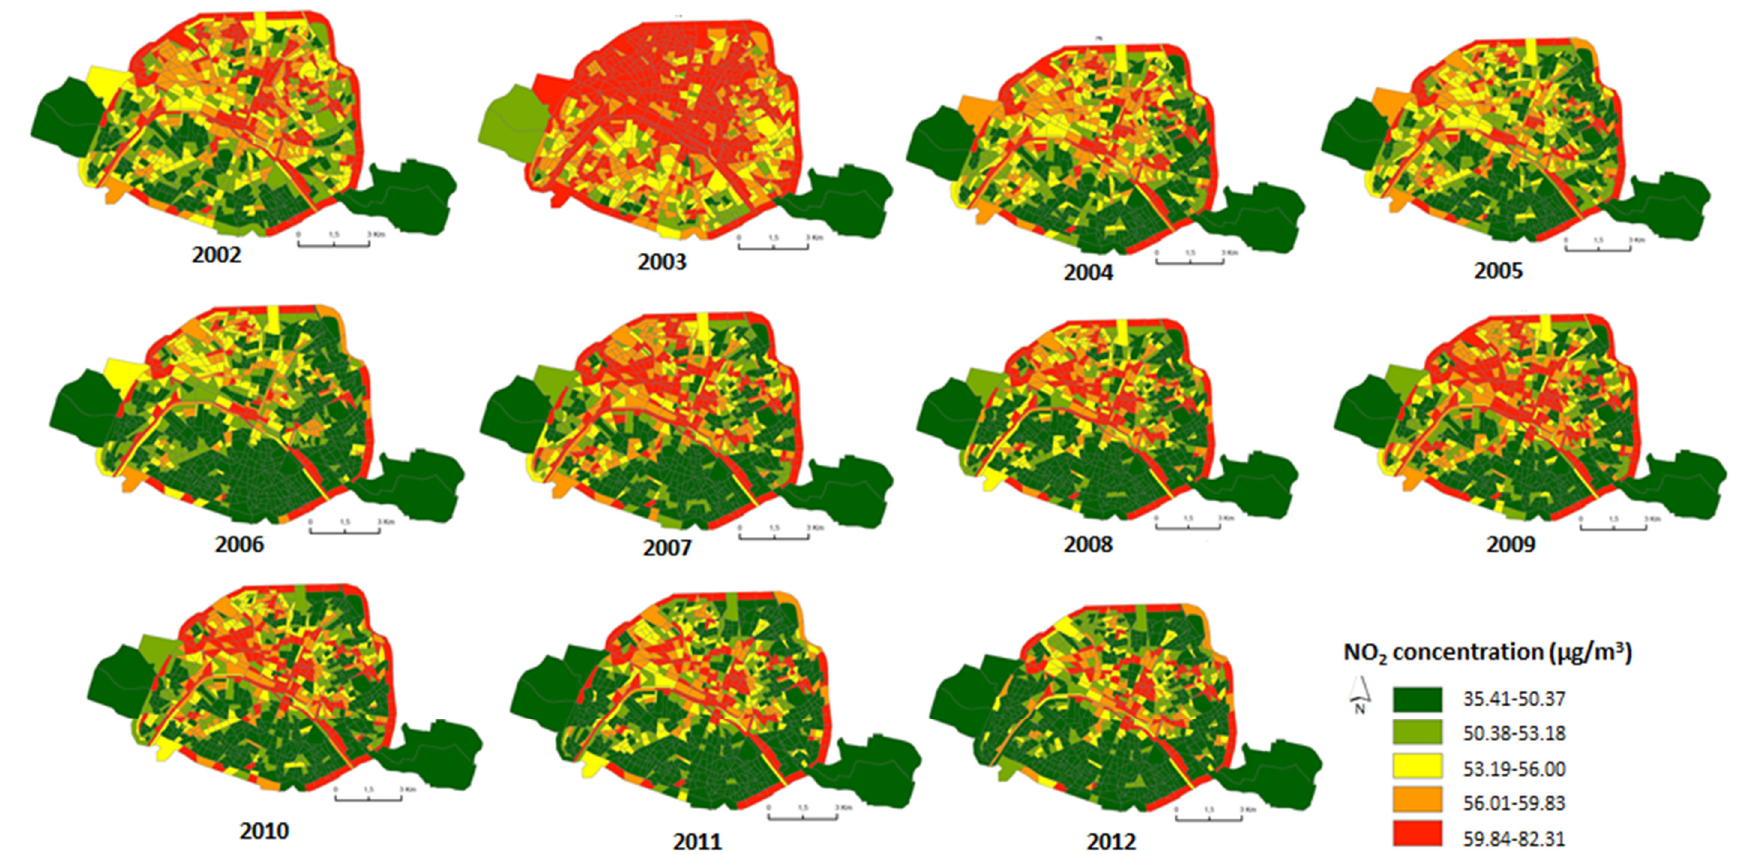
Figure 2. Spatiotemporal distribution of the modeled annual averages of NO 2 concentrations at the census block level over the 2002 − 2012 period in Paris.